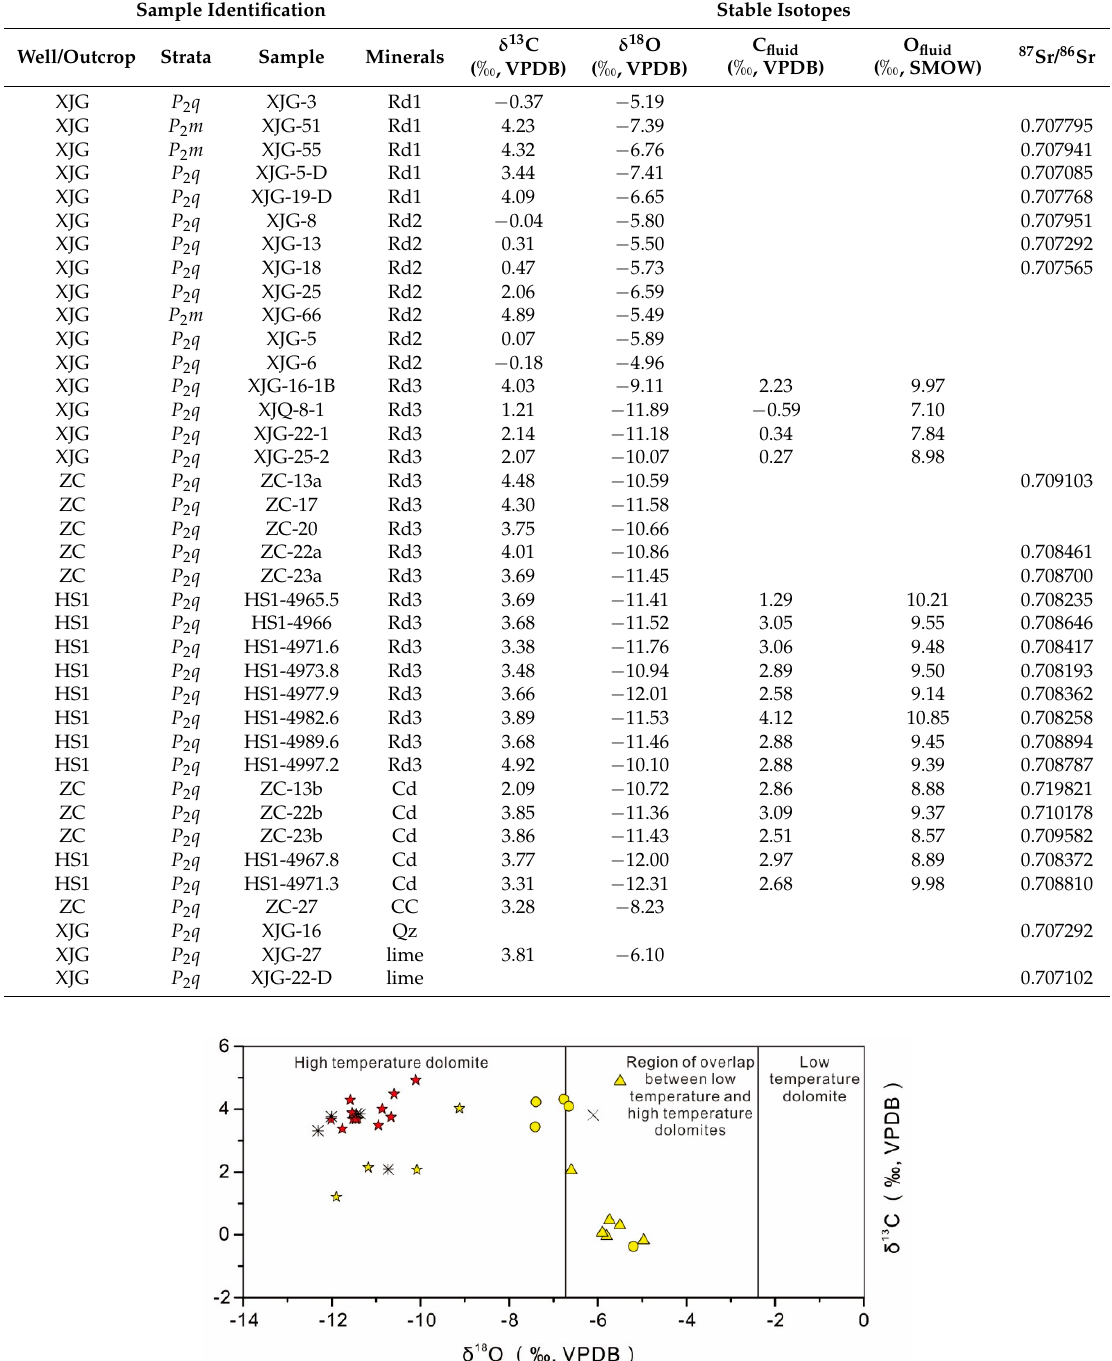
Table 2. Stable isotope data of limestone and dolomite in Middle Permian in SW Sichuan Basin.